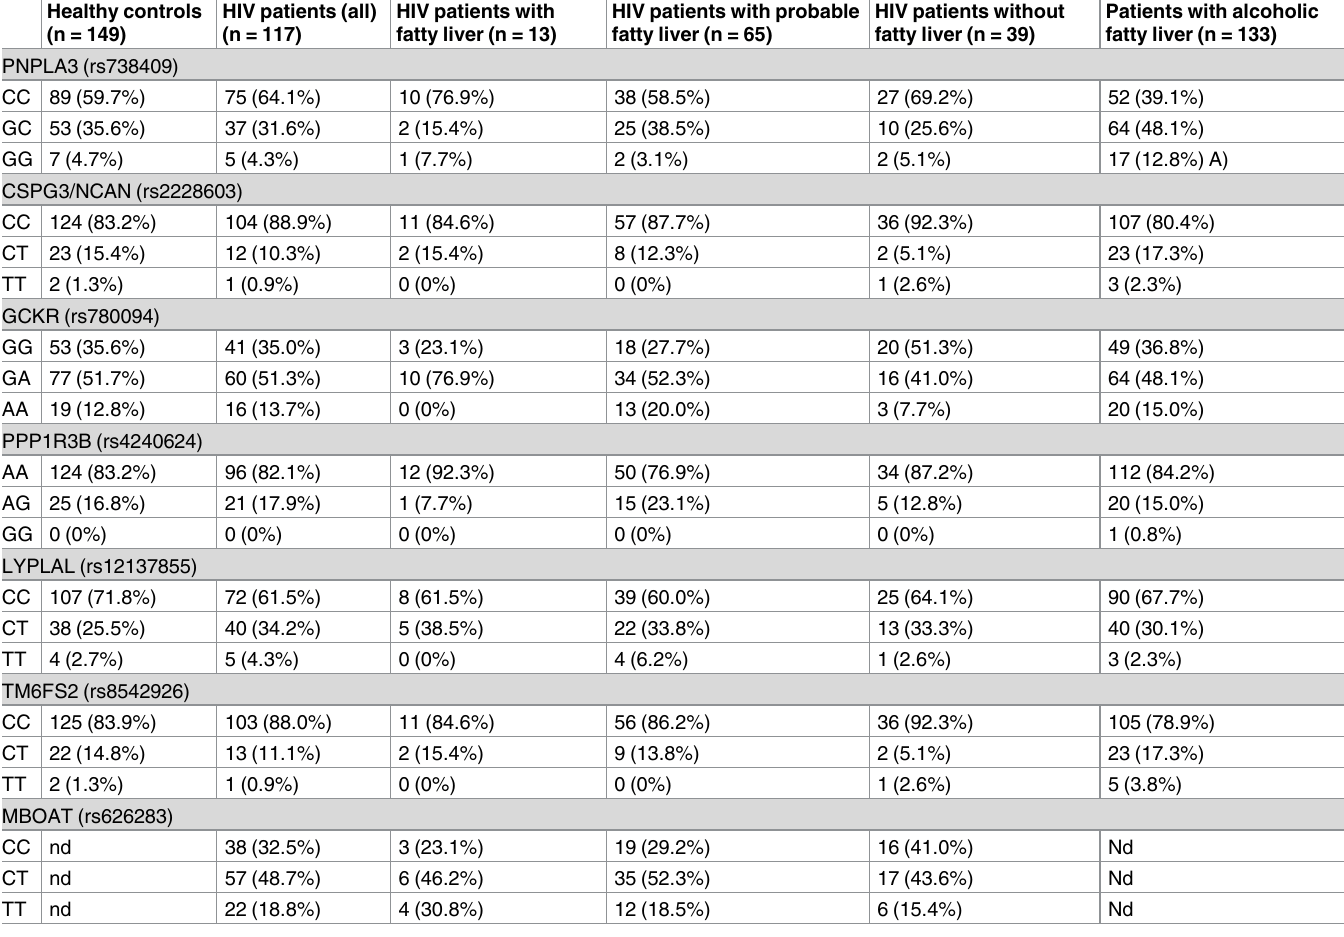
Table 2. SNPs allele distribution in HIV positive patients, HIV positive patients with fatty liver, healthy controls and alcoholic fatty liver. Healthy controls (n =